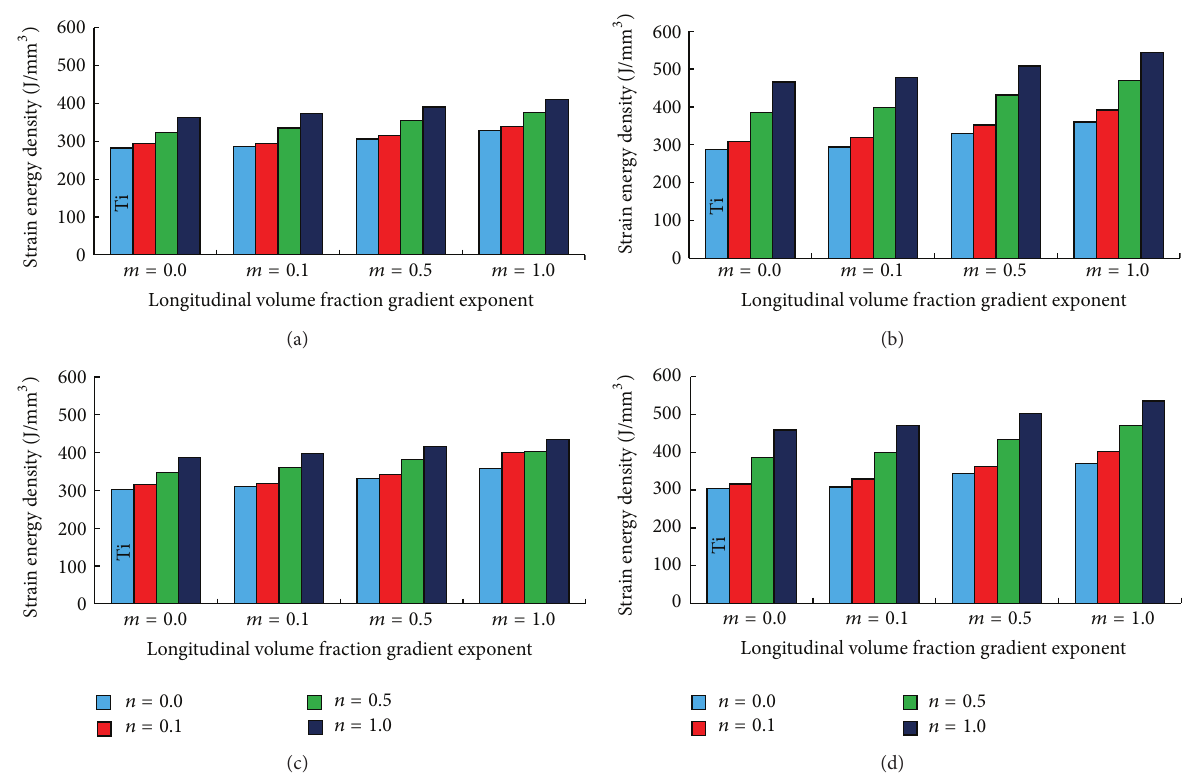
Figure 4: Strain energy in the spongy portion of the proximal metaphysis of the femur due to the implantation of (a) normal walking- cemented prostheses, (b) normal walking-non-cemented prostheses, (c) stair climbing-cemented prostheses, and (d) stair climbing-non- cemented prostheses (the legend shows the radial volume fraction gradient exponent change). 𝑛 is radial volume fraction gradient